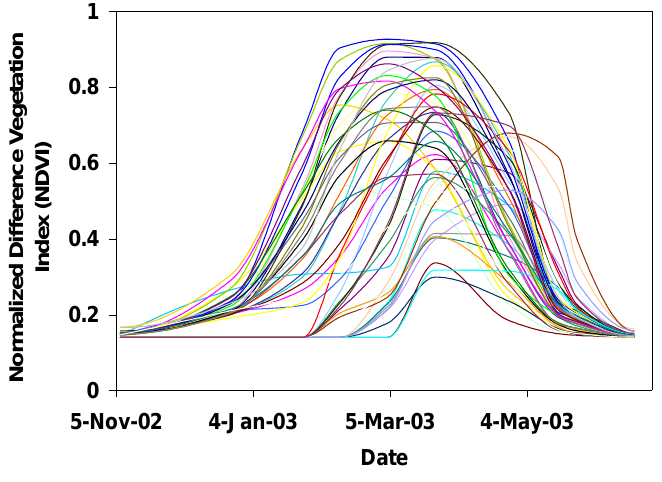
Figure 2. Profiles of NDVI corresponding to 50 classes of winter wheat identified by K- means classification. A cubic interpolation method was used to determine the values of NDVI between two satellite